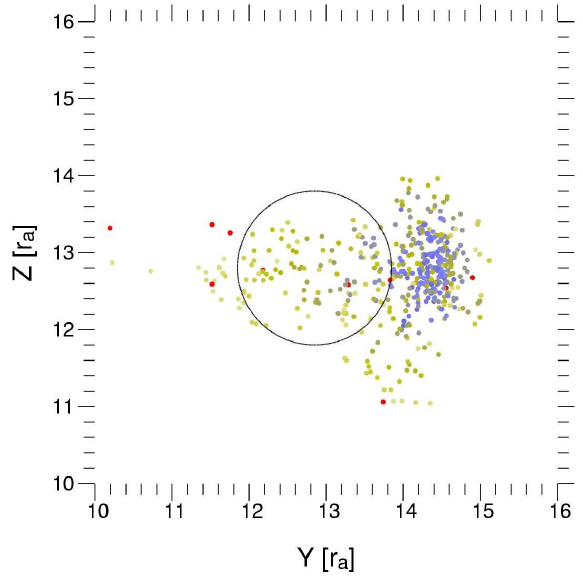
Fig. 7b. (y, z) positions of the dawn electrons plotted in Fig.